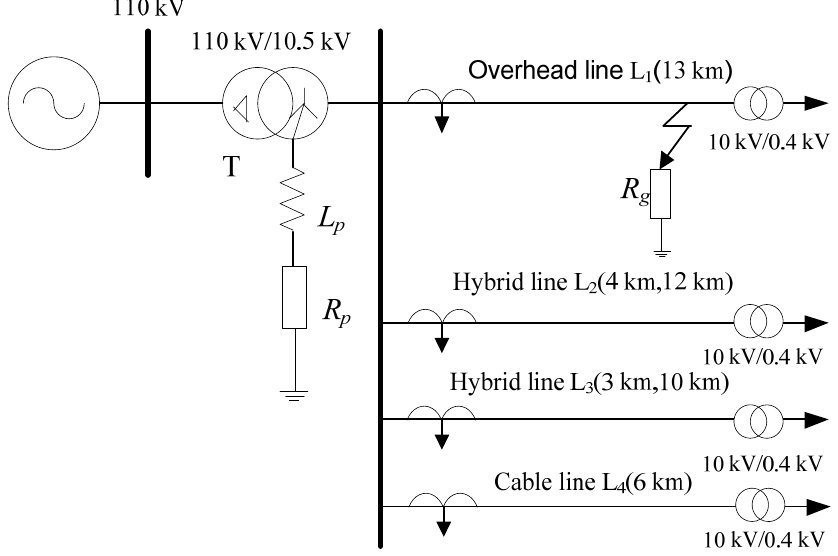
Figure 6. ATP simulation model for radial distribution network.